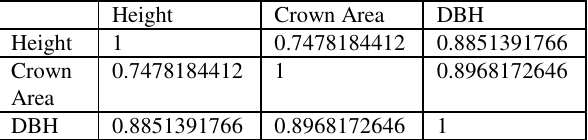
Table 1. The distribution for the nDSM of a single tree DataFit delivered the model given in equation (1) for the relation between height h , crown area A and diameter at breast height DBH with the parameters given in Table 2.